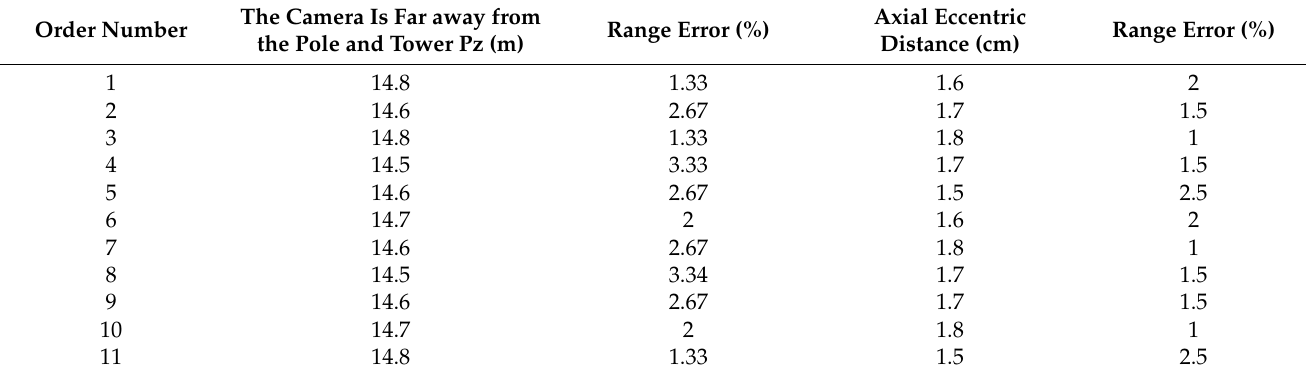
Table 1. Indoor test camera detection results.